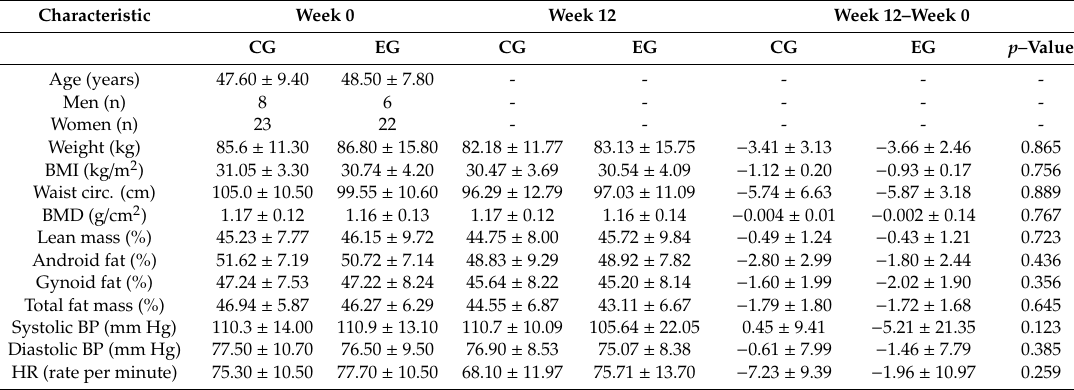
Table 1. Baseline characteristics and anthropometric parameters of the study participants before and after the